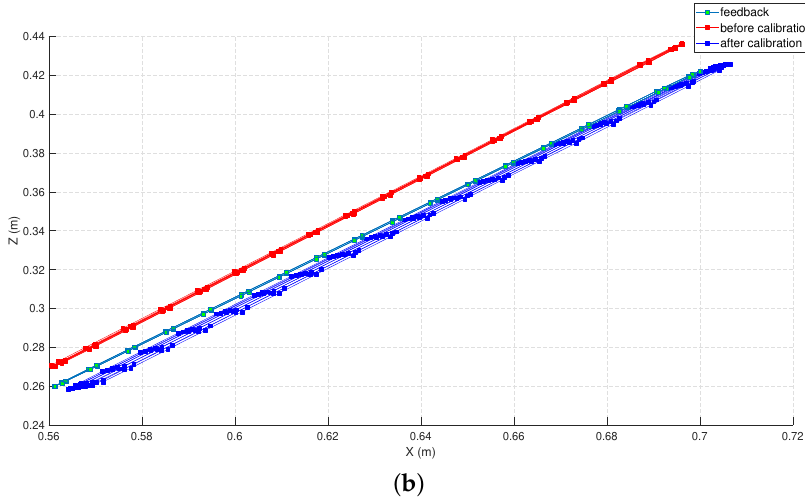
Figure 6. Estimated end-effector position before and after calibration (down-sampled by 5) plotted along with the feedback positions. ( a ) Top view (X-Y plane). ( b ) side view (X-Z plane).